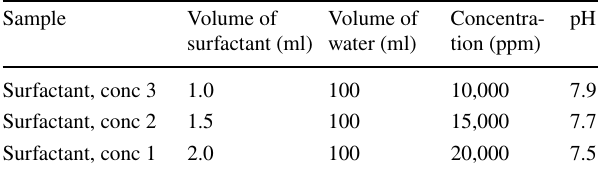
Table 3 Compositions of surfactants utilized in surfactant flooding